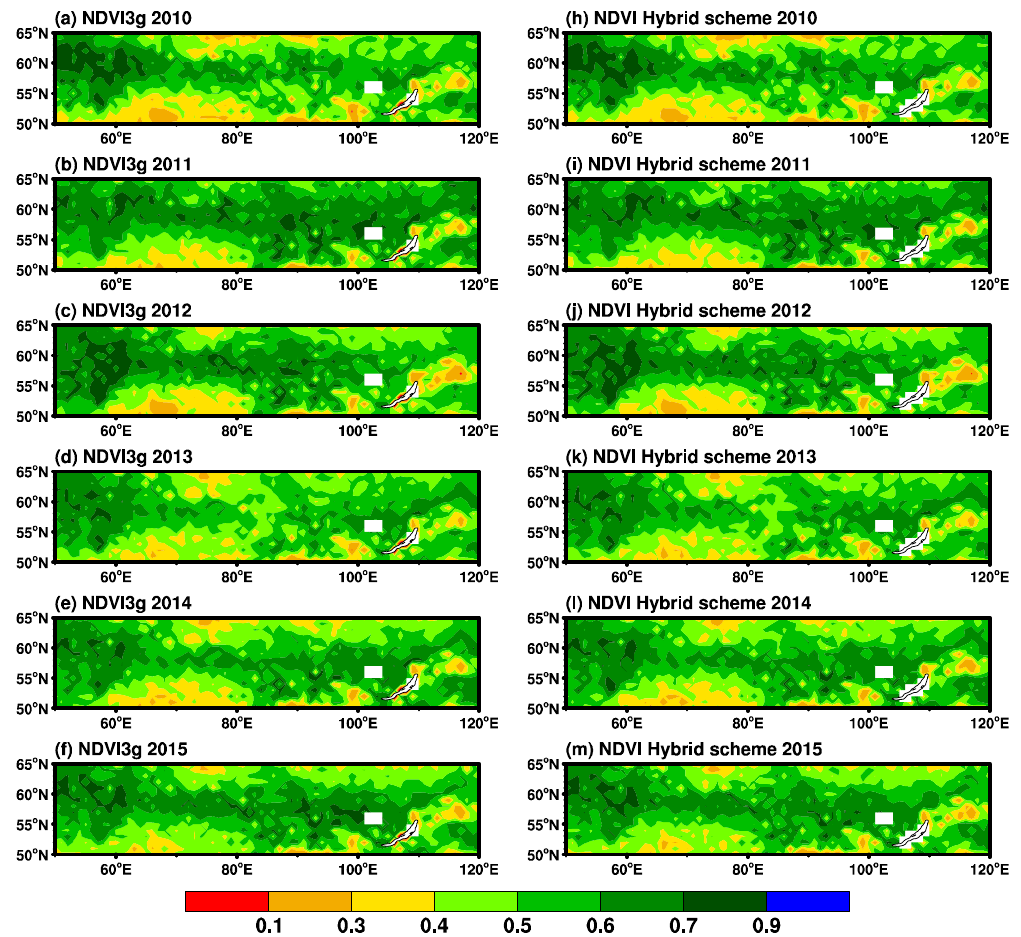
Figure 9. Spring (April–May–June (AMJ)) NDVI over Eurasia during 2010–2015, where ( a – f ) are from the NDVI3g data and ( h – m ) are from the independent hindcast results of the hybrid scheme.